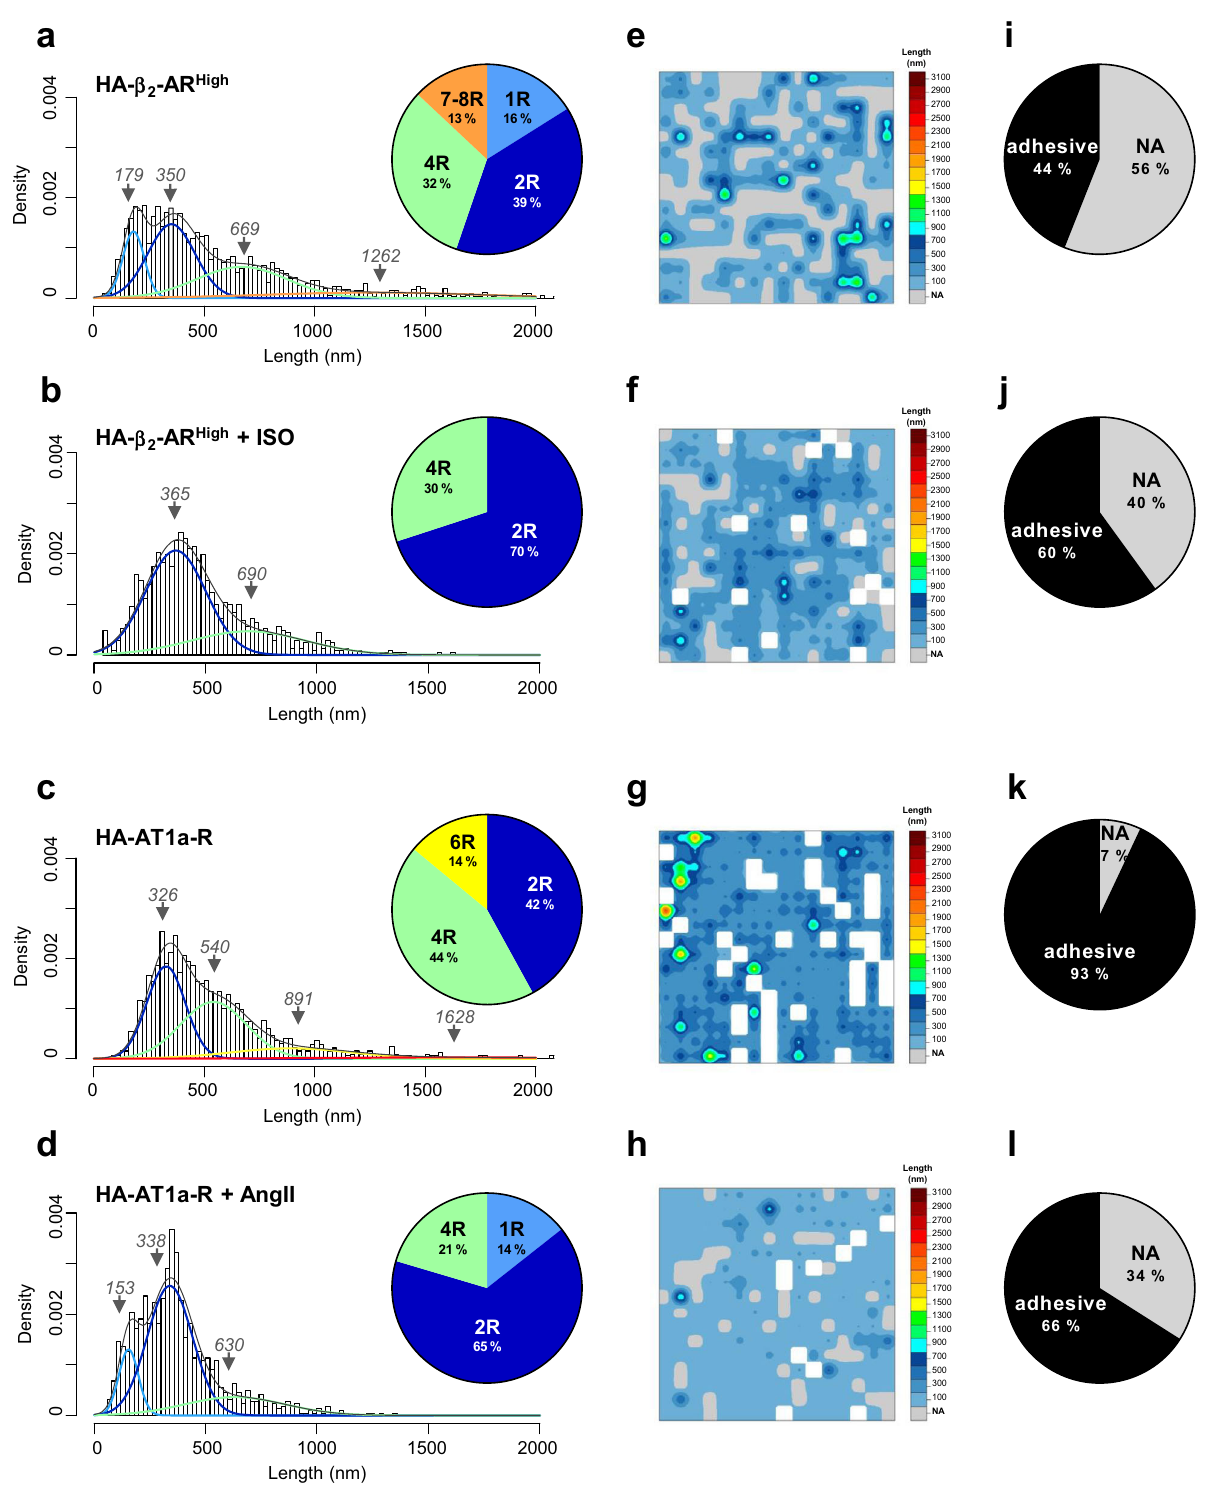
Fig. 6 Mapping agonist stimulation on GPCR oligomerization and their spatial organization using FD-based SMFS. SMFS experiments were conducted on WTT-CHO cells transiently transfected with 1 µ g of vector encoding HA- β 2 -AR (HA- β 2 -AR High ) or HA-AT1a-R and treated or not ( a , e , i , c , g , k ) with 10 µ M isoproterenol (ISO) ( b , f , j ) or angiotensin II (AngII) ( d , h , l ) respectively for 20 min. Unfolding distances were analyzed by fi tting with a Gaussian mixture according to the BIC-based method. Each Gaussian population was assigned to a GPCR oligomeric state ( 1 receptor/monomer = 1 R; 2 receptors/ dimer = 2 R; 3 receptors/trimer = 3 R … ) based on their theoretical length, and Gaussian weight is presented in the pie charts ( a , b , c , d ). The 256 unfolding distances resulting from one representative cell area (3 × 3 µ m 2 ) are depicted as a spatial map ( e , f , g , h ). The proportions of adhesive and non-adhesive (NA) events are shown in the pie charts ( i , j , k , l ). For each condition, at least nine cells from at least three independent experiments were analyzed. Note that a , e , i , c , g , k are similar to Fig. 4a, e, i, d, h, l or Fig. 5a, d, g to facilitate